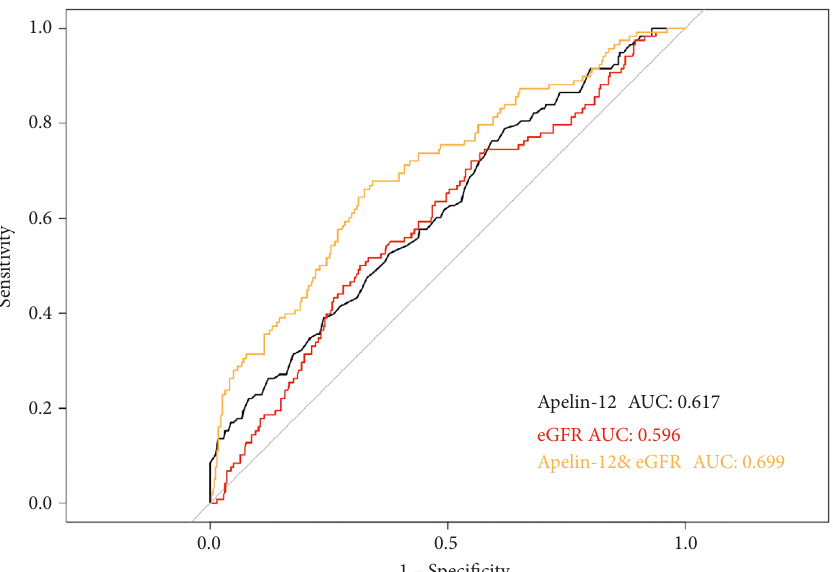
Figure 3: ROC curves for the combination of apelin-12 and eGFR, and either apelin-12 or eGFR alone. eGFR: estimated glomerular filtration rate; ROC: receiver operating